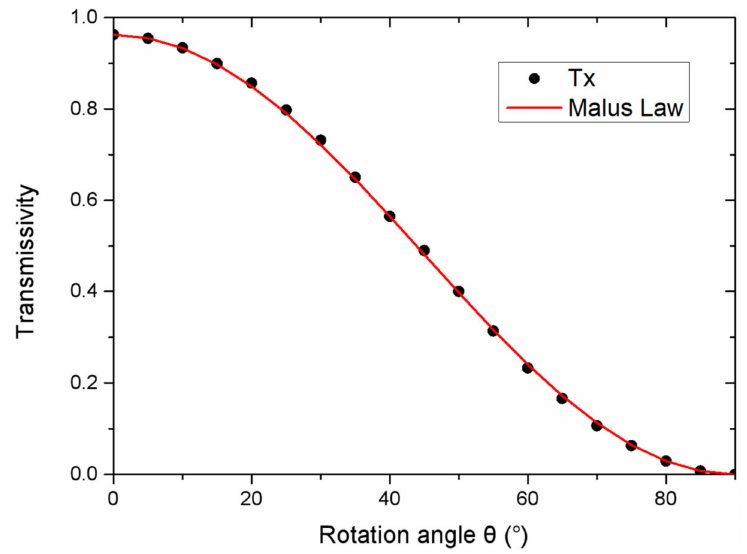
Figure 4. The curve of transmittance changing with the rotation angle of the nano structure.